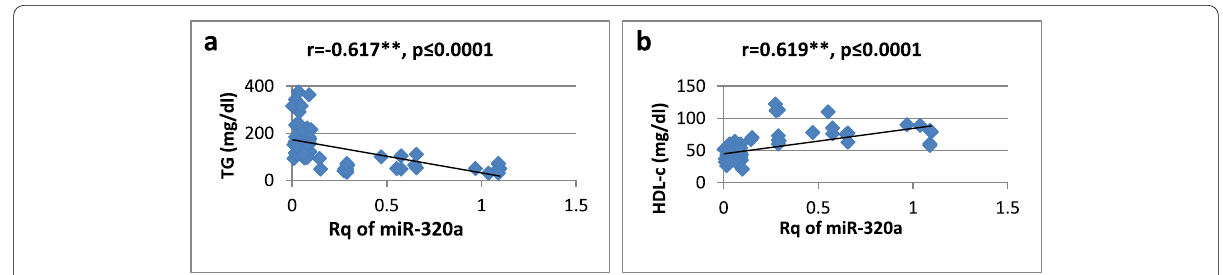
Fig. 10 a , b Correlation coefficient between Rq of microRNA 320‑a and both TG ( r significant at p ≤